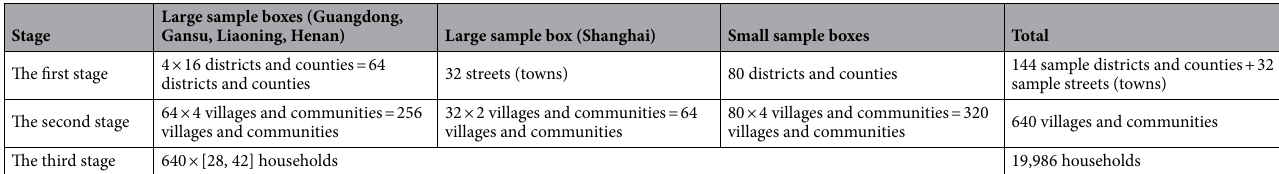
Table 1. CFPS three-stage sampling procedure. In the third stage, theoretically, 31.23 households are sampled from 640 sample frames on average, [28, 42] represents the range of households sampled from each sample frame, that is, at least 28 households are sampled from each sample frame, and at most 42 households are sampled from each sample